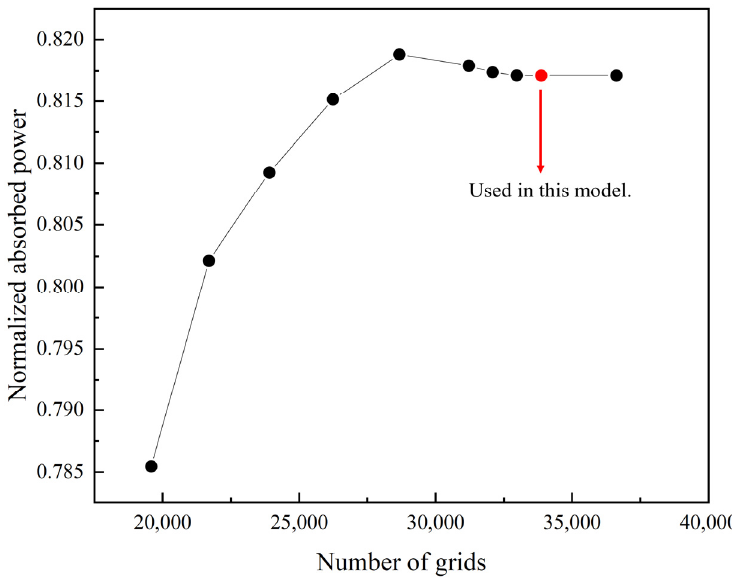
Figure 4. Grid-independent validation of the simulation.